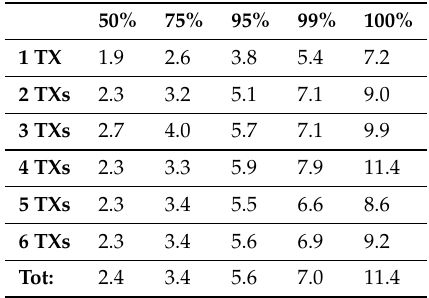
Table 4. Percentiles of σ θ ( ◦ ) for all